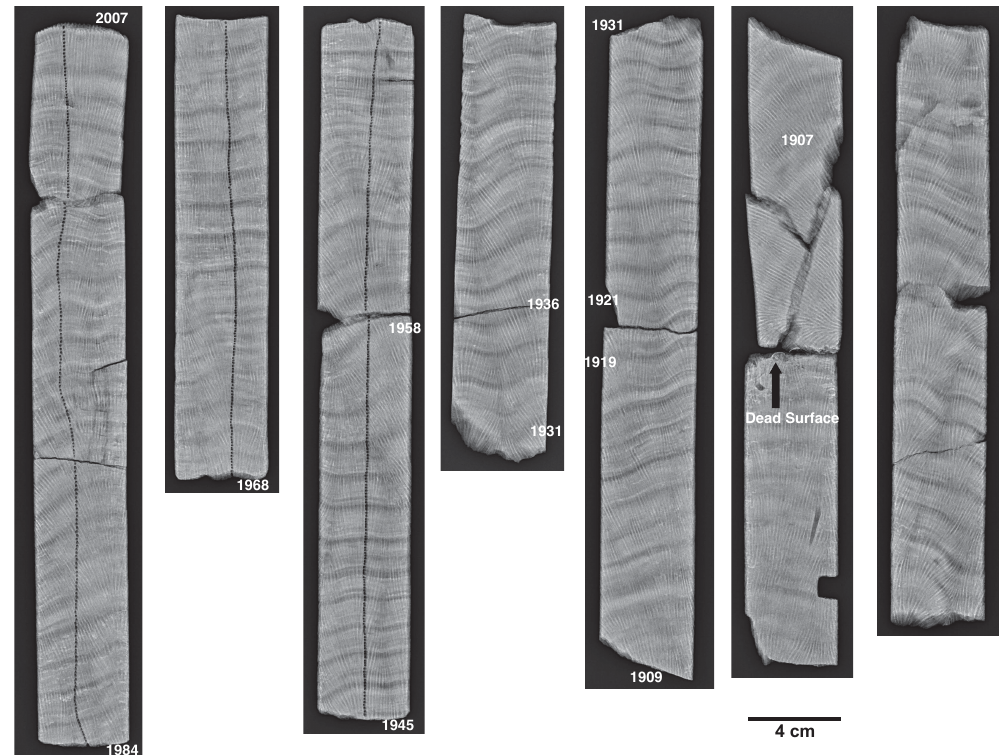
Figure A2. X-ray negative print for core sections of core Cabri with sampling lines (milling holes) indicated. Start or end years for each core section indicated. Note the dead surface before 1907 that is most probably related to a past coral bleaching event.